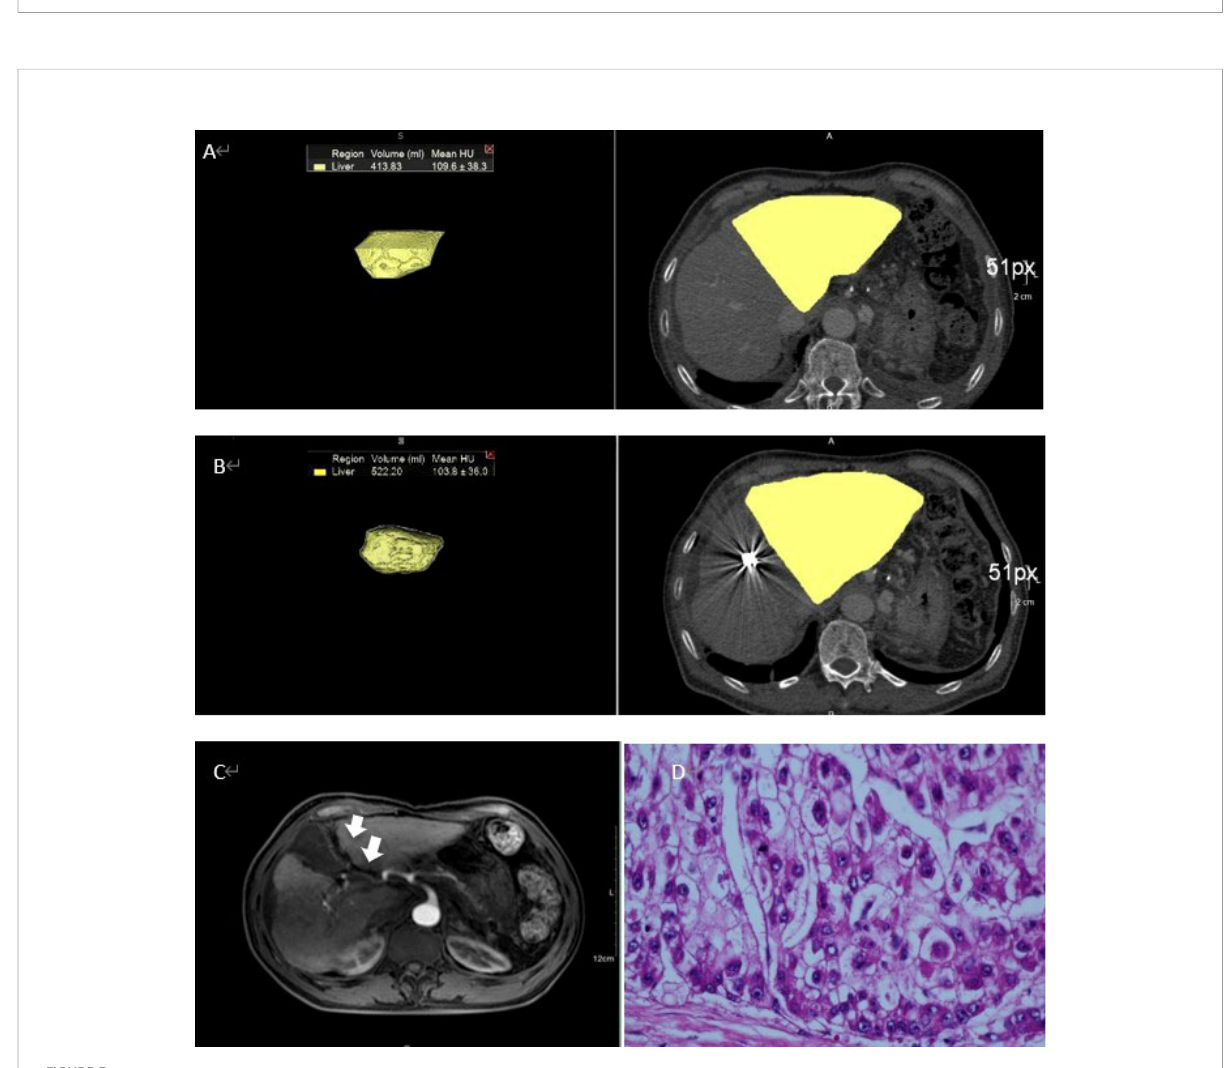
FIGURE 3 A 65-year-old man with HCC treated with PMA combined with PVE (A) Volume of left lobe of liver was 413.83ml according to CT. (B) Ten days after PMA and PVE, volume of left lobe of liver increased to 522.20ml. (C) The plane of PMA could be clearly seen (white arrow). (D) The histologic diagnosis was